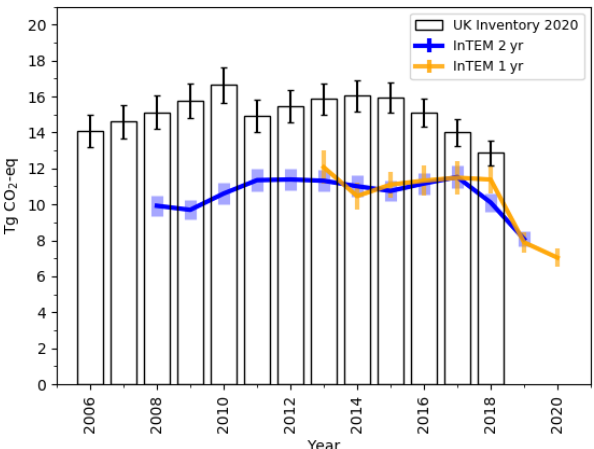
Figure 7. Total UK HFC emission estimates (HFC-125, HFC-134a, HFC-143a, HFC-152a, HFC-23, HFC-32, HFC-227ea, HFC-245fa, HFC-365mfc and HFC-43-10mee) in TgCO 2 -eqyr − 1 from the UK inventory submitted to the UNFCCC in 2020 (black), InTEM annu- alized 2-year inversion (blue) and InTEM 1-year inversion (orange). Note that HFC-43-10mee ( < 0 . 02TgCO 2 -eqyr − 1 ) is included in the InTEM data from 2011 when the observations start. The uncer- tainty bars represent 1 σ